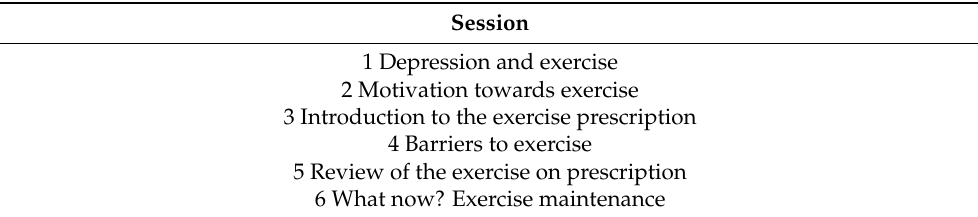
Table 1. Description of the content of the IDEA group